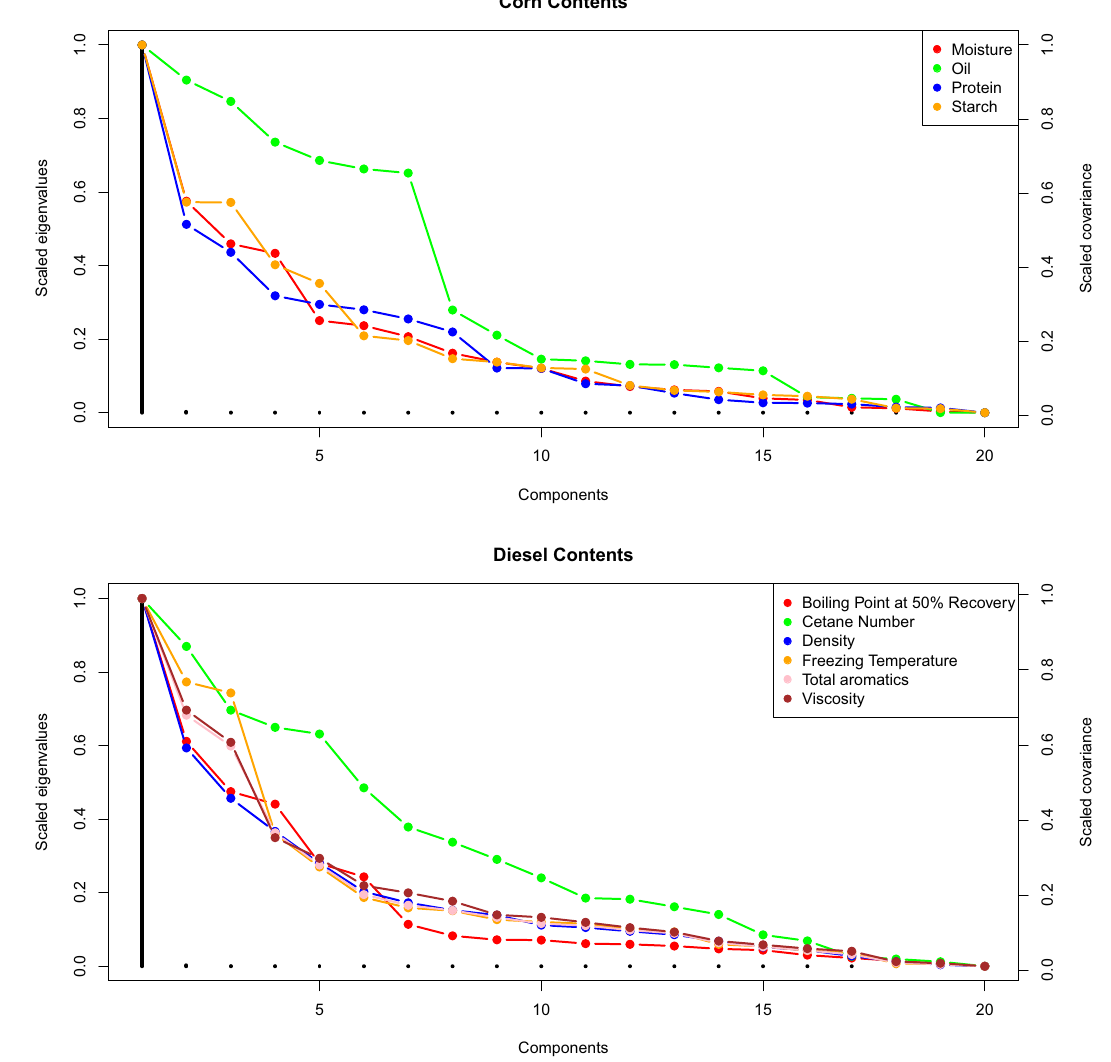
Figure 3. Data properties related to corn and diesel spectrum and their contents are extracted for understanding the prediction behavior. The eigenvalue (sorted in descending order) presents the covariance of spectral matrix. The points indicates the covariance (sorted in depending order) between principal components and each